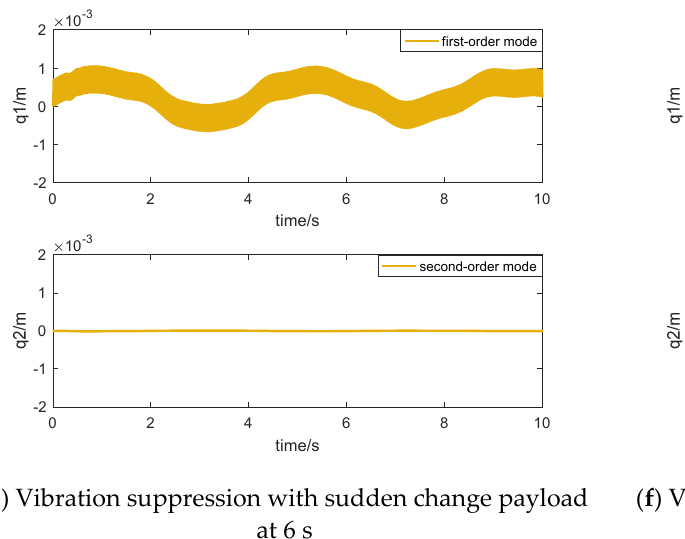
Figure 12. Tracking performances and vibration suppression of the manipulator with uncertainties in different conditions with varying payload.